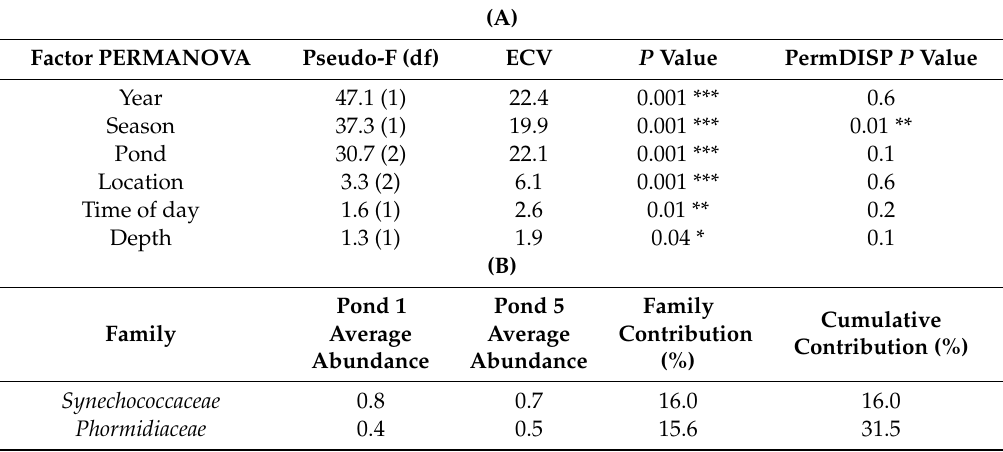
Table A4. A. PERMANOVA analysis testing the di ff erences in the Cyanobacteria phylum between year (2012, 2013), season (early wet and dry), pond number (P1, P2 and P5), location within the ponds (inlet, middle and outlet), time of day (6 am and 1 pm) and depth of the water sampled (surface and benthic). The term “df” means degrees of freedom, “ECV” square root of estimates of components of variation indicating the e ff ect size as average% SV dissimilarity due to that factor (residual ECV 39.7). P value is based on > 9912 unique permutations; “PermDISP” permutational distance-based test for homogeneity of multivariate dispersions for main factors. *** P value = 0.001; ** P value < 0.01; * P value < 0.05. B. Similarity percentages (SIMPER) analysis identifying species contributions to the change between ponds 1 and 5 for Cyanobacteria families: Synechococcaceae and Phormidiaceae . Average dissimilarity between ponds 1 and 5 = 19.4%. Bray-Curtis similarity cut o ff =